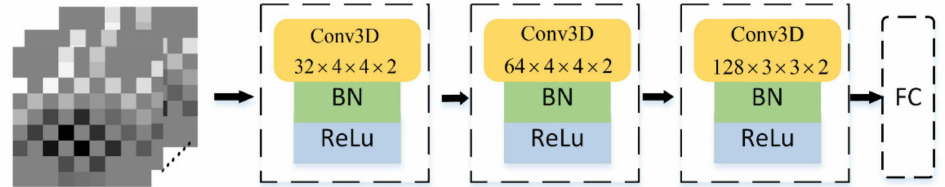
Figure 8. Flow chart of spatial feature extraction based on 3D-CNN. The spatial features of the EEG are extracted through a series of 3D convolution modules and fully connected layers.